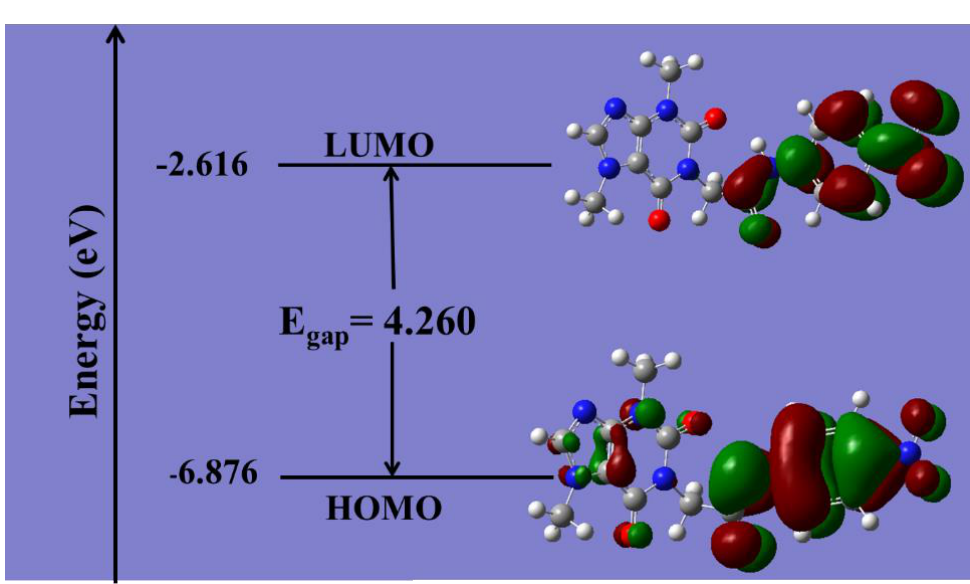
Figure 12. The FMO analysis; HOMO and LUMO of T-2-PNPA at the ground state at B3LYB/6- 311++G(d,p). Table 2. The calculated global reactivity indices and energetic parameters for T-2-PNPA .